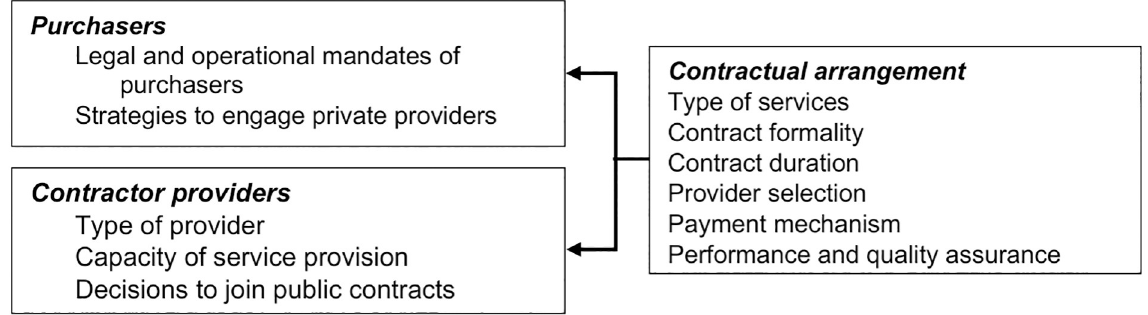
Fig 1. Conceptual framework for